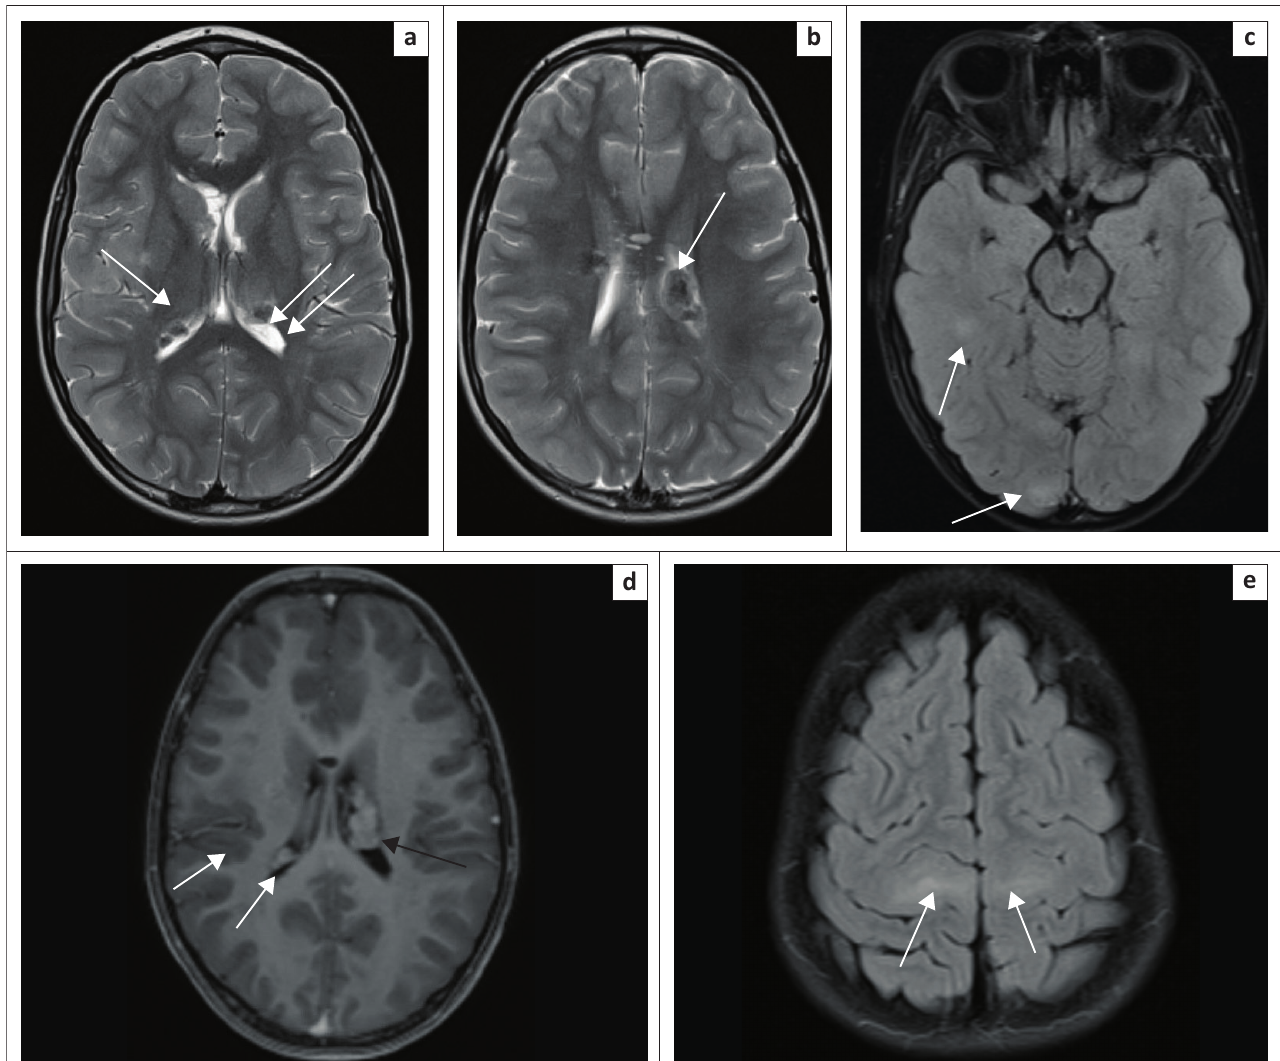
FIGURE 2: (a) Eleven-year-old male. T2W axial demonstrates numerous hypointense subependymal nodules (white arrows). (b) T2W axial demonstrated large subependymal giant cell astrocytoma (SEGA), with hypointense signal (white arrow). Additional subependymal nodule (black arrow). (c) Fluid inversion axial demonstrates hyperintense tubers (white arrows). (d) Axial T1-weighted precontrast image. Iso-intense subependymal nodule (white arrow). Subependymal giant cell astrocytoma (black arrow). (e) Axial fluid-attenuation inversion recovery (FLAIR) hyperintense white matter radial bands (white